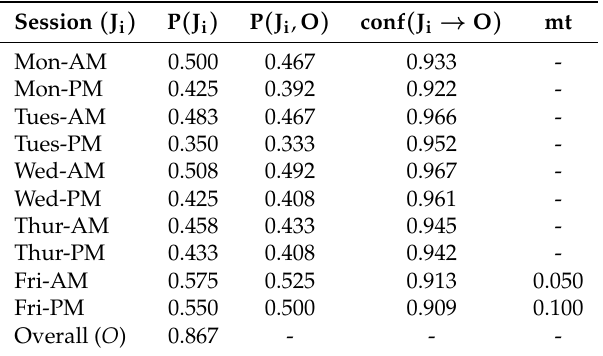
Table 8. Identifying target sessions—2018/19, T t = 119.